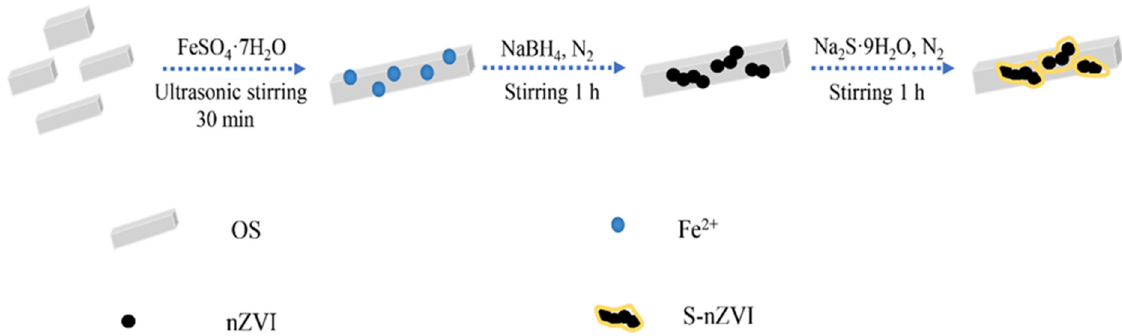
Figure 1. Schematic diagram of S-nZVI@OS synthesis.